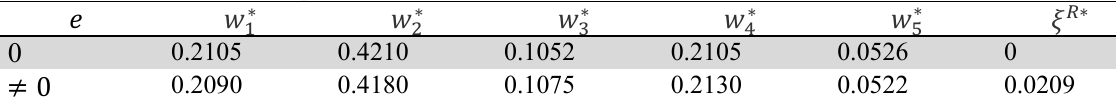
Numerical results of example 2